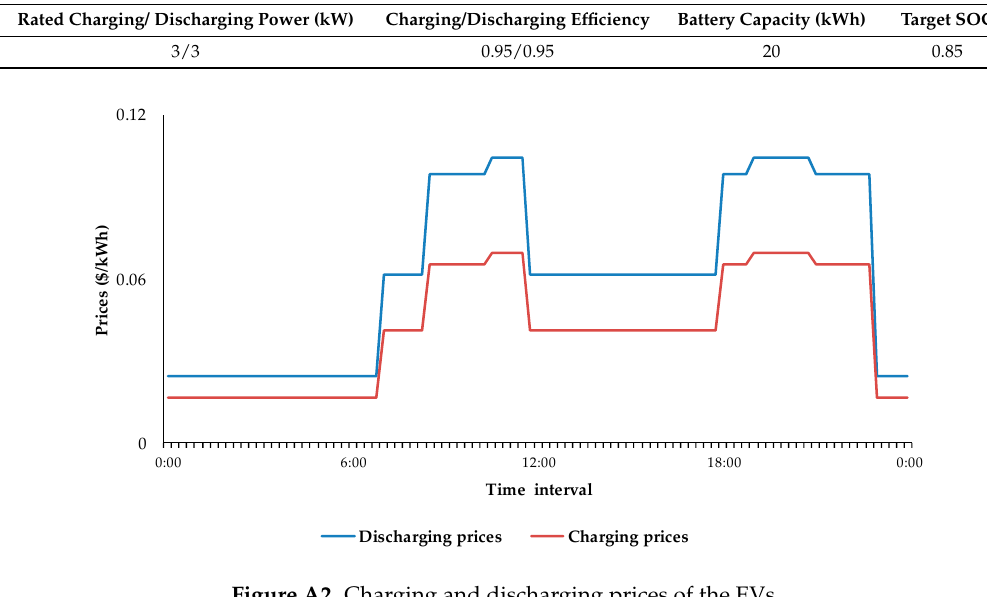
Figure A2. Charging and discharging prices of the EVs. Table A3. Parameters of the CSACS.